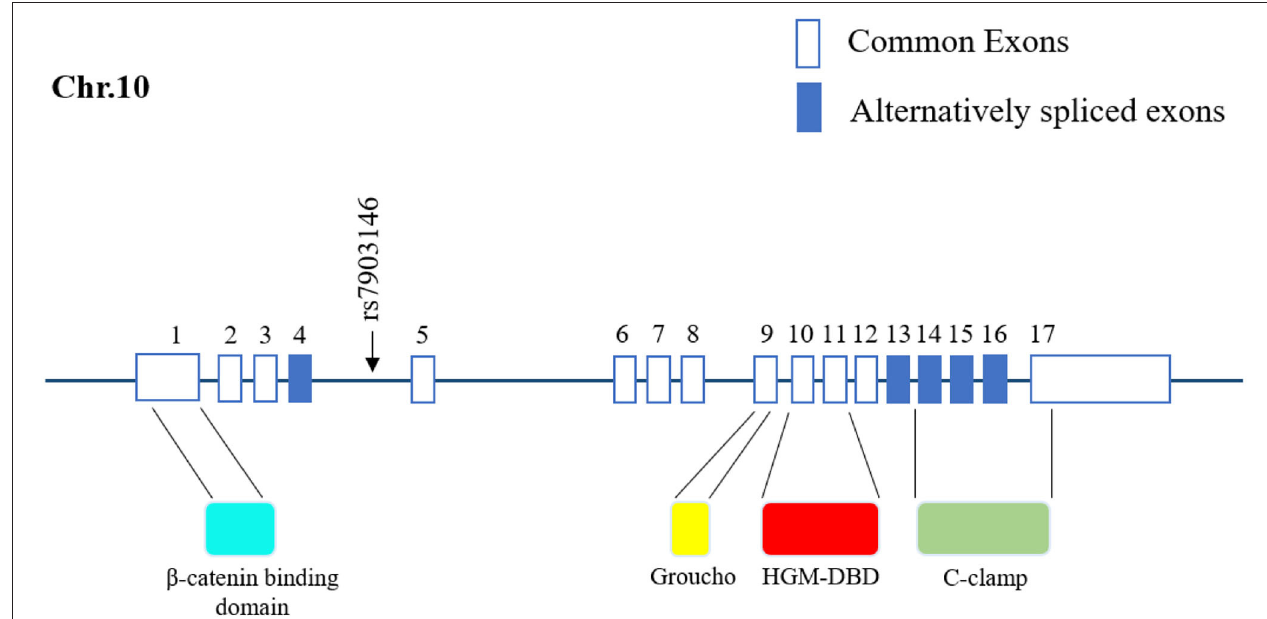
FIGURE 1 | Location of rs7903146 in human TCF7L2 . Representative 17 exons and location of rs7903146 on human TCF7L2 . Alternatively spliced exons are colored, and the black arrow represents alternative transcription start sites. rs7903146 is located in exon 4 of TCF7L2. TCF7L2 comprises several domains, including